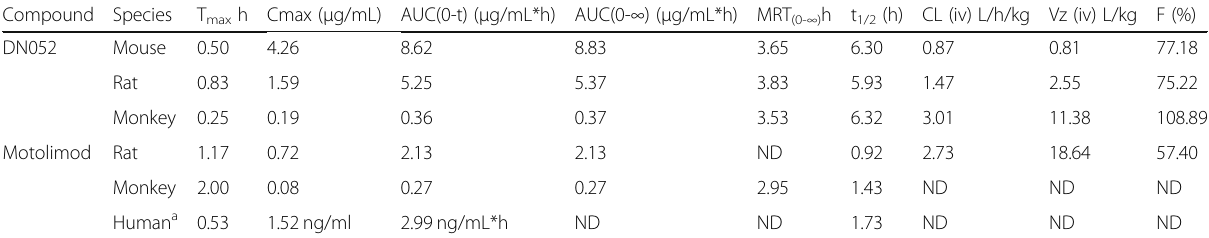
Table 2 PK profiles of DN052 and motolimod